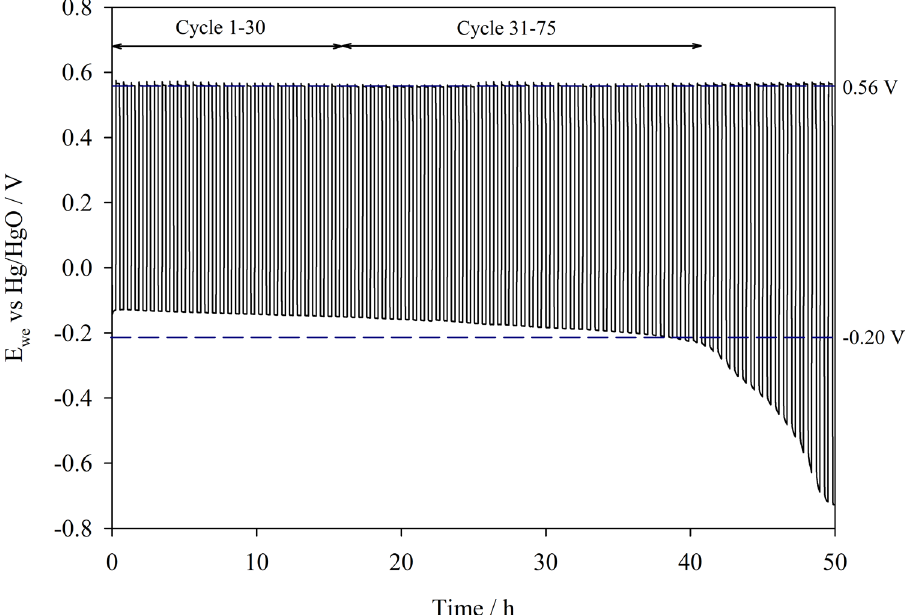
Figure 8. Galvanostatic cycling performance of oxygen electrodes MnO x + Ni-Fe-Co(OH) 2 in a tri-electrode Zn–air set-up over 50 h at 20 mA cm −2 with 30 min cycle periods, in static electrolyte 4 M NaOH + 0.3 M ZnO at 333 K. Compressed air was supplied at 200 cm 3 min −1